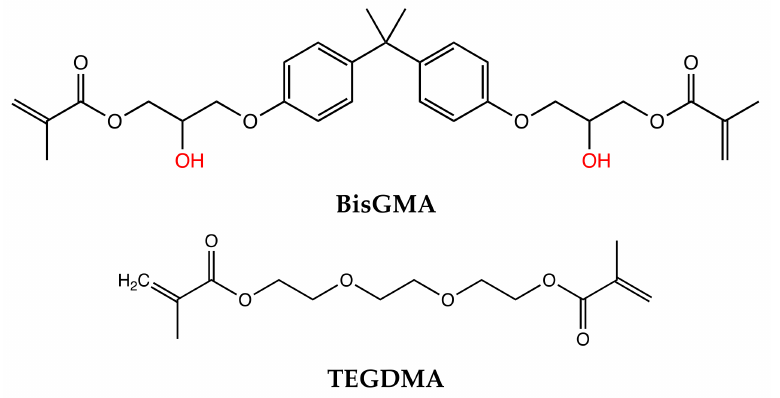
Figure 4. Chemical Structure of resin monomers. Bisphenol A-glycidyl methacrylate (BisGMA) and Triethylene glycol dimethacrylate (TEGDMA).